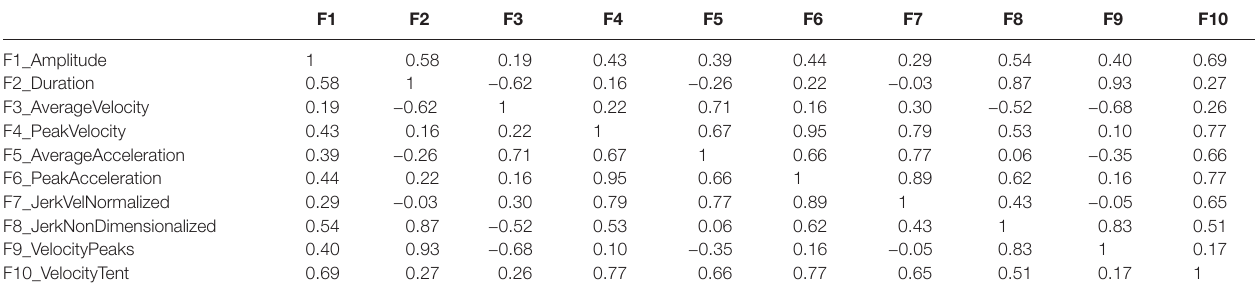
TaBle 3 | Correlation matrix of extracted features; F =